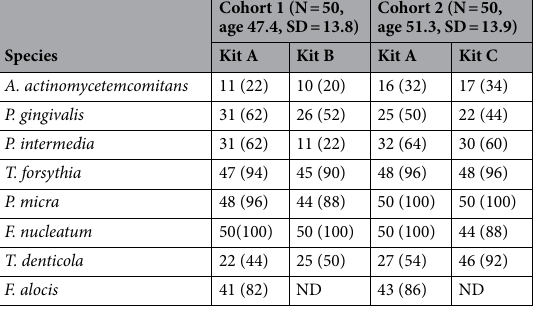
Table 2. Number of samples (%) tested positive for selected periodontal pathogens by three different commercial qPCR test kits. ND not analyzed by kit B and kit C.